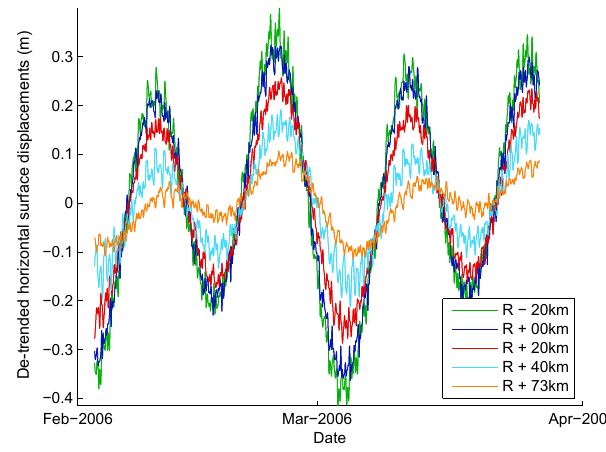
Figure 1. Linearly detrended horizontal displacements on the RIS reproduced by a tidal fit to the original measured data. Measure- ments are shown from five GPS stations at 20km downstream of the grounding line ( R − 20km), at the grounding line ( R + 00km) and distances of 20, 40 and 73km upstream from the grounding line ( R + 20km, R + 40km and R + 73km, respectively). Data at 10km upstream is not included for the sake of